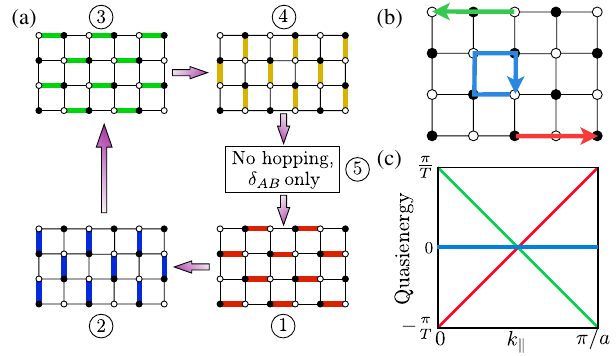
FIG. 2. Two-dimensional tight-binding model exhibiting anomalous Floquet edge modes. (a) Driving protocol. Hopping amplitudes are varied in a spatially homogeneous but chiral, differentiating the time-periodic way. A sublattice potential (cid:2) AB two types of sites in the bipartite lattice (filled and open circles) is applied throughout. During four of the five equal-length phases of the cycle, hopping along one of the four distinct bond types is allowed, with amplitude J (bold lines). During the fifth phase, all hopping amplitudes are zero, while the sublattice potential remains constant. (b) In the simple case ¼ 0 , particles in the bulk move in closed JT ¼ 5 (cid:1)= 2 , (cid:2) AB trajectories encircling plaquettes, and the Floquet operator is the identity. Chiral edge modes propagate along the boundaries. (c) Floquet spectrum for the case described in